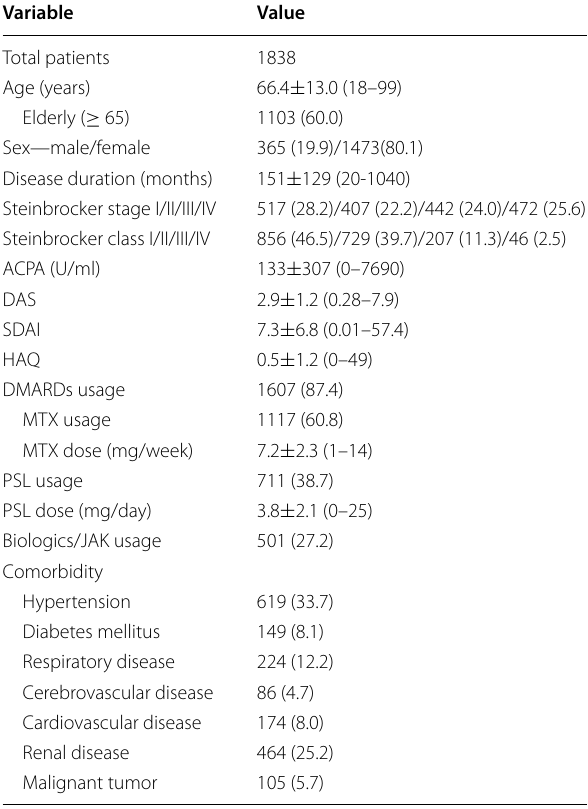
Values are expressed as the number of patients (%) or the mean ACPA anticyclic citrullinated peptide antibody, DAS Disease Activity Score-28 joint count, HAQ Health Assessment Questionnaire, DMARDs disease-modifying anti-inflammatory drugs, MTX methotrexate, PSL prednisolone, JAK Janus kinase inhibitors, SD standard